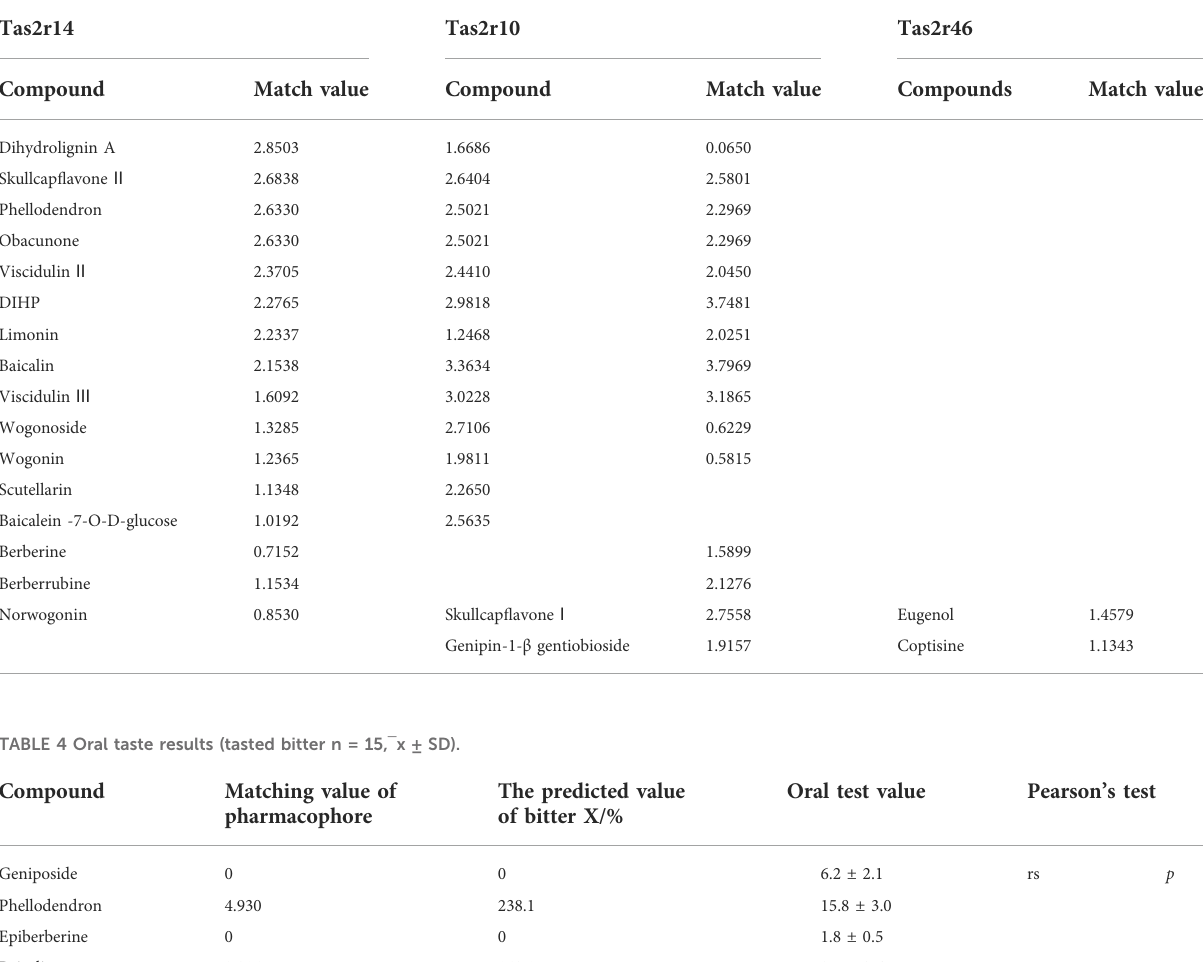
TABLE 3 Bitter compounds in HLJDD screened using pharmacophores.